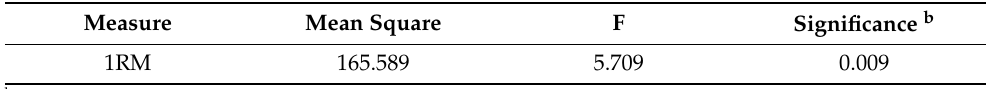
Figure 3. 1RM measured using conventional press machine (plate 1RM) and 1RM measured using hydraulic press machine (hydraulic 1RM). Mean hydraulic 1RM represents the average of the three paired hydraulic 1RMs. Table 1. Repeated-measures ANOVA of plate 1RM and hydraulic 1RMs.